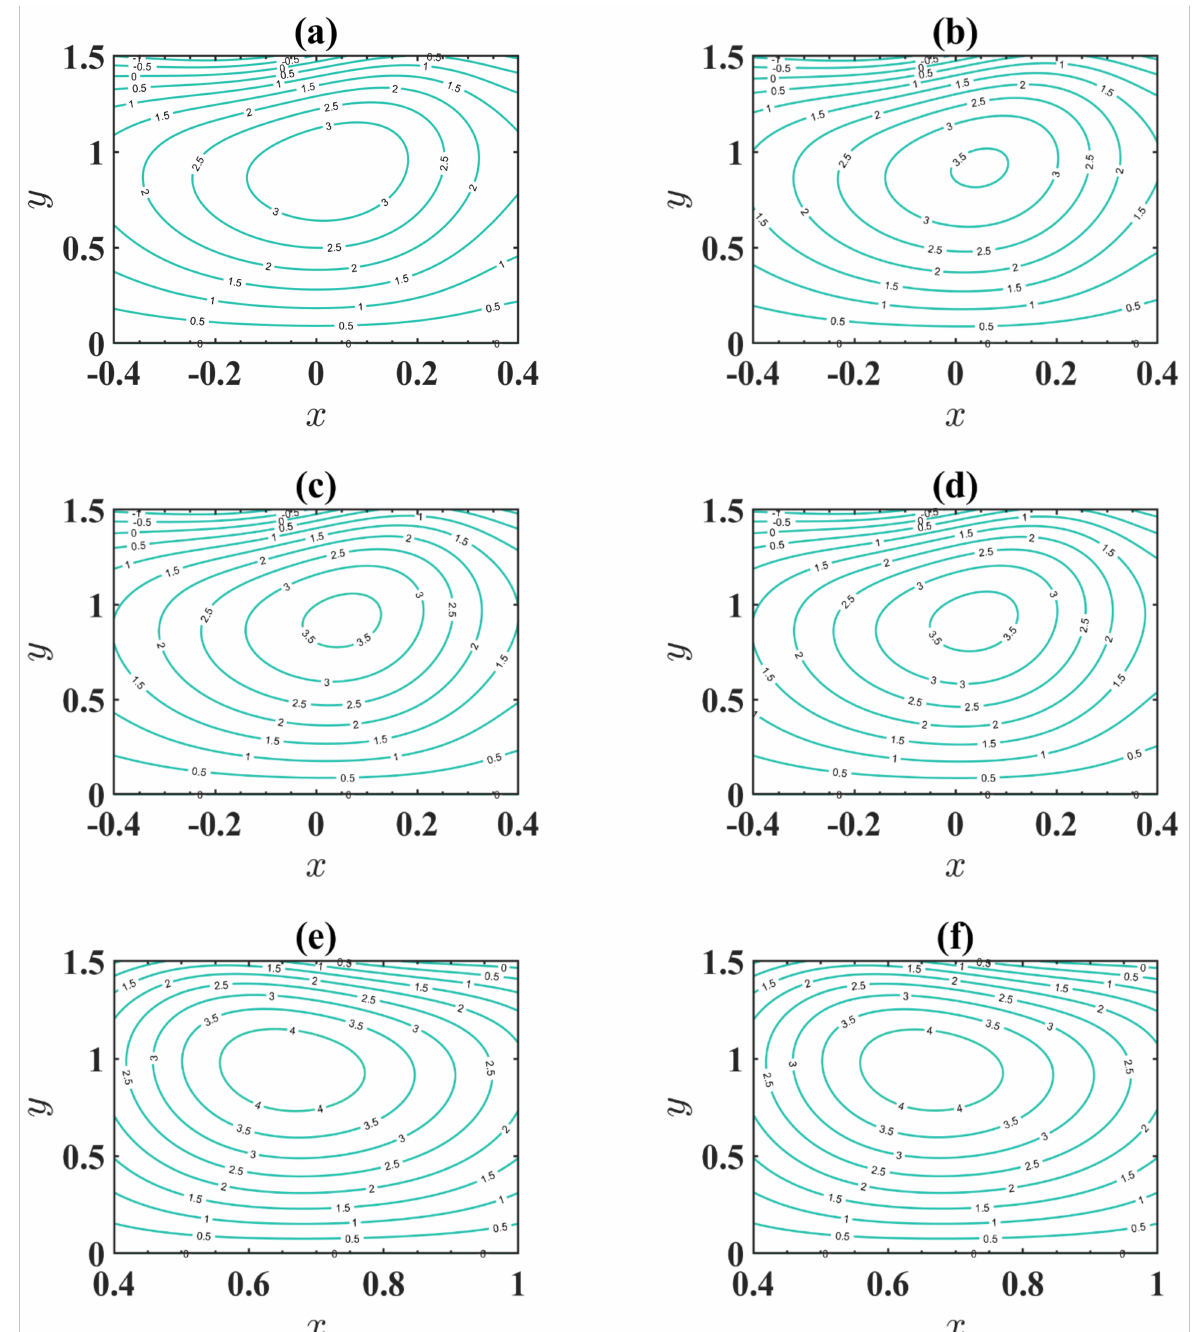
Figure 13. Streamlines for varying ( a ) E 1 = 0.09, E 2 = 0.04, E 3 = 0.4, E 4 = 0.002, E 5 = 0.02, ( b ) E 1 = 0.1, E 2 = 0.04, E 3 = 0.4, E 4 = 0.002, E 5 = 0.02, ( c ) E 1 = 0.1, E 2 = 0.045, E 3 = 0.4, E 4 = 0.002, E 5 = 0.02, ( d ) E 1 = 0.1, E 2 = 0.045, E 3 = 0.45, E 4 = 0.002, E 5 = 0.02, ( e ) E 1 = 0.1, E 2 = 0.045, E 3 = 0.45, E 4 = 0.006, E 5 = 0.02, and ( f ) E 1 = 0.1, E 2 = 0.045, E 3 = 0.45, E 4 = 0.006, E 5 =